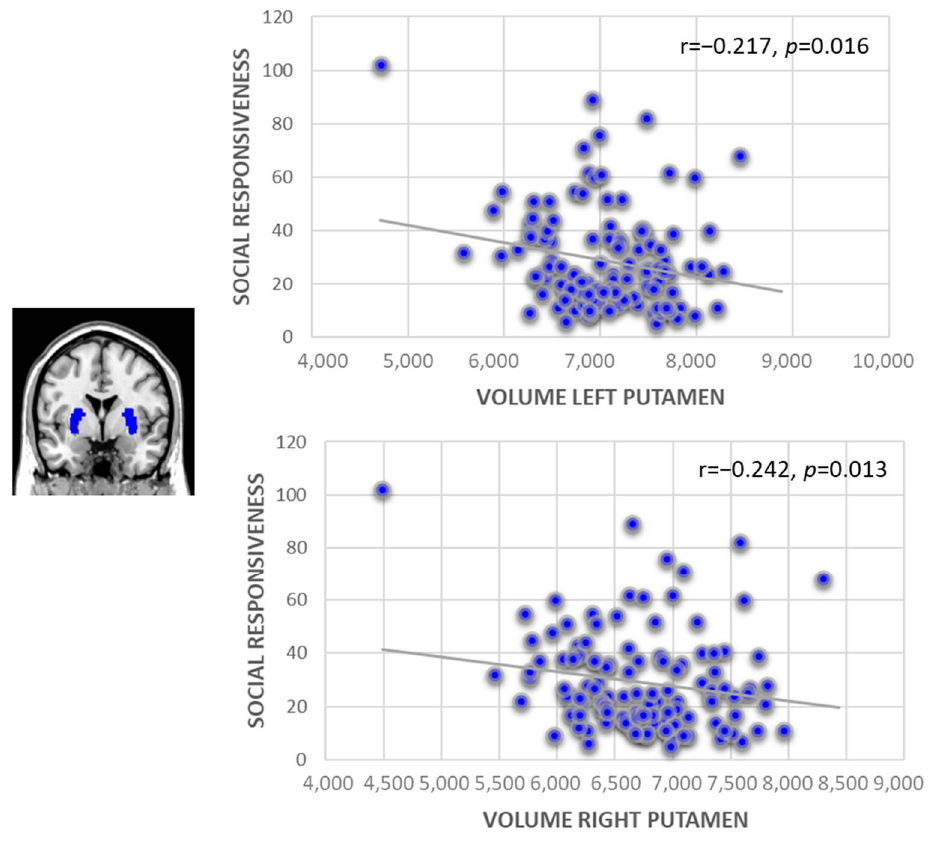
Figure 2. Prediction of social responsiveness by volumetric changes in the left and right putamen in male adolescents.